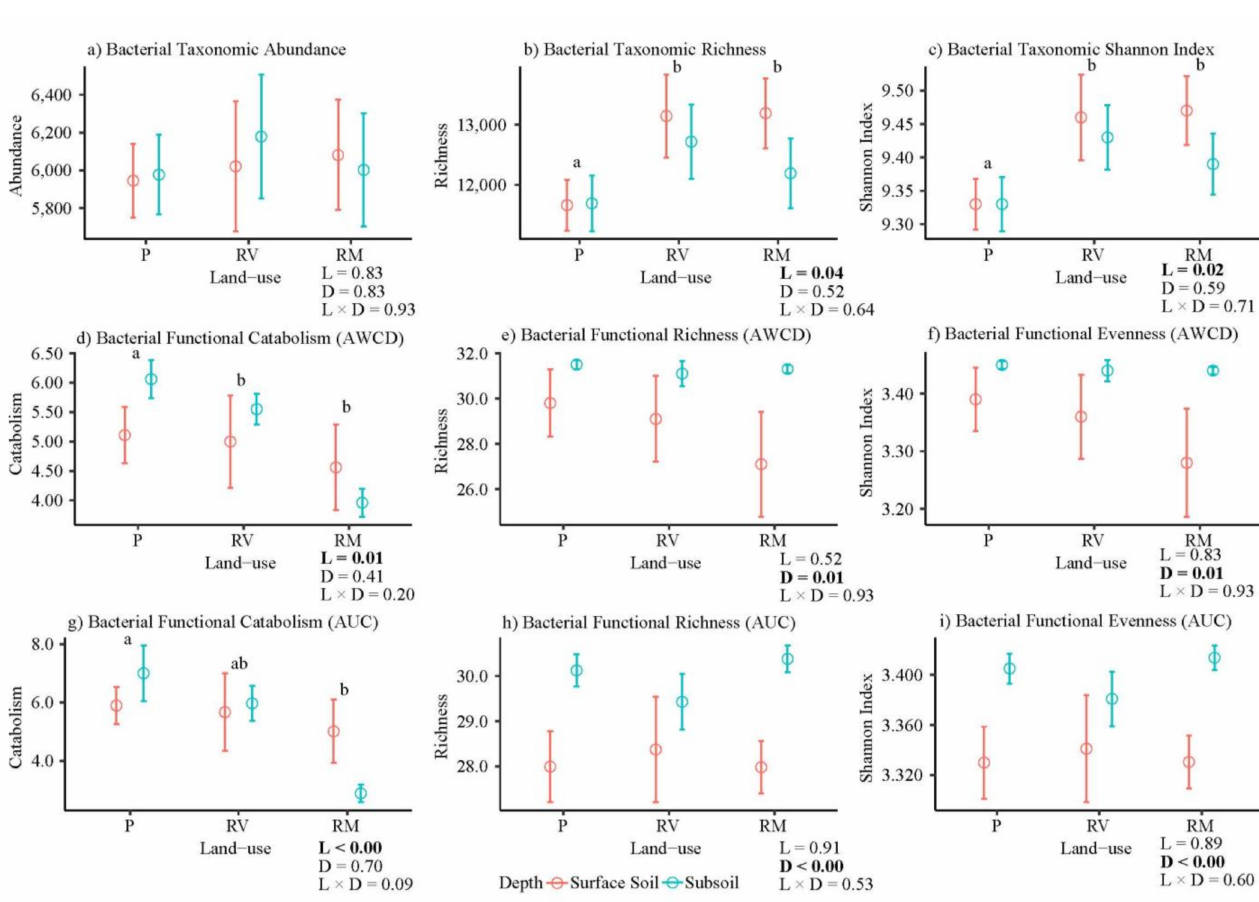
Figure 4. Overall bacterial taxonomic and functional diversity (abundance/catabolism ( a , d , g ), richness ( b , e , h ), Shannon’s diversity index ( c , f , i )). Values represent means according to land use (P = pasture, RV = revegetated, and RM = remnant) and colored by soil depth. Bars represent standard error of the mean, p values for GLM shown below graphs (L = land-use, D = depth, and L × D = interaction), bold indicates significant difference ( p values < 0.05). Letters indicate significant pairwise differences among land uses (across depth) as determined by Tukey HSD